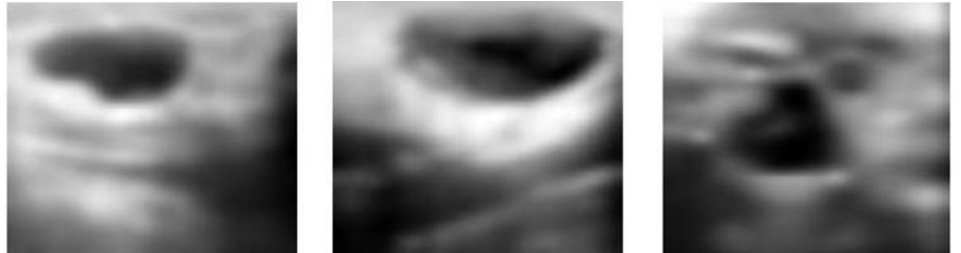
Figure 5. Filtered image.